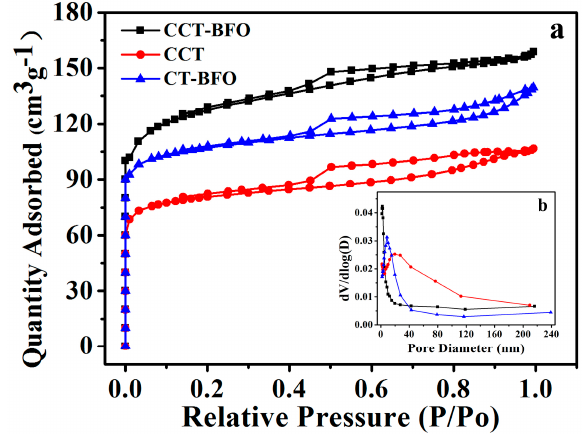
Figure 5. ( a ) Nitrogen adsorption/desorption isotherms of CCT-BFO, CT-BFO, and CCT respective and ( b ) the pore size distribution of three samples. Table 1. The specific surface area and the micropores volume ratio of the CCT-BFO, CT-BFO, and CCT, respectively.